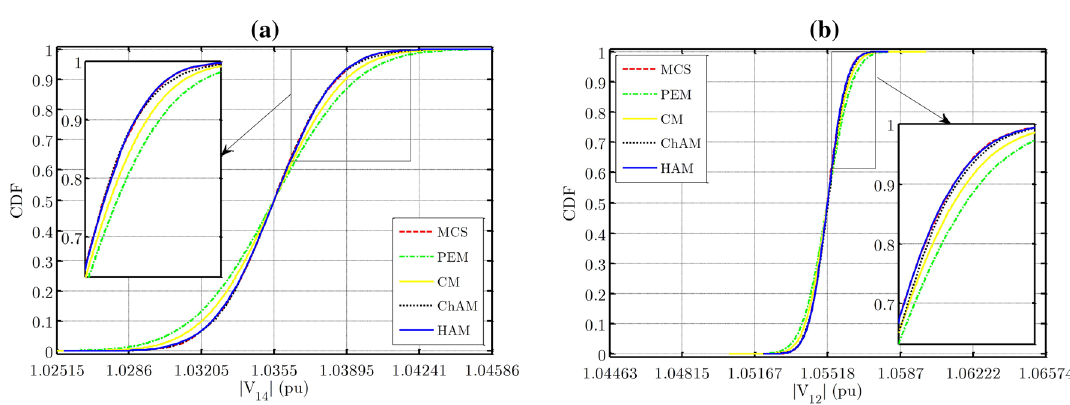
Fig. 3 Cumulative distribution function of voltage magnitude at a bus 14, b bus 12, in IEEE 14-bus test